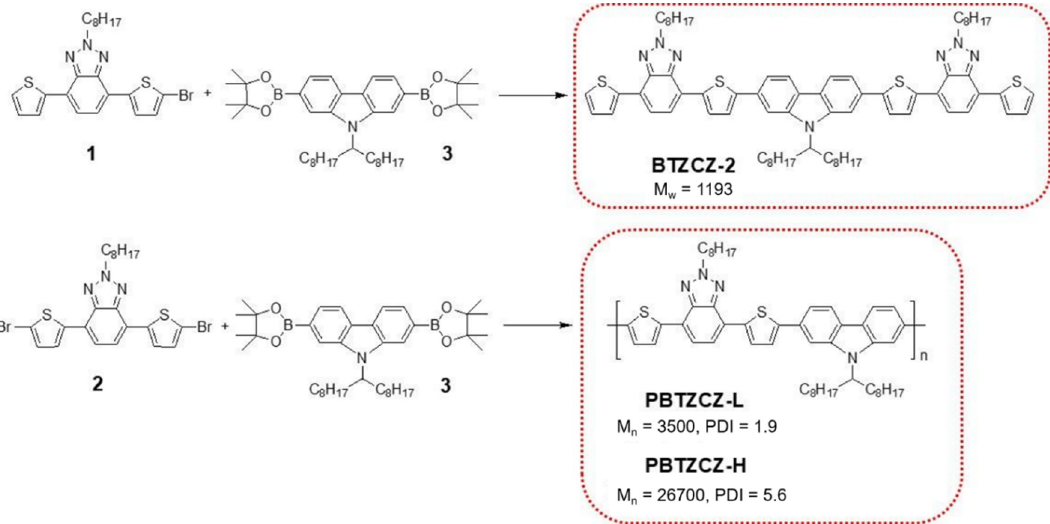
Table 1. Physical properties of the BTZCZ-2 , PBTZCZ-L , and PBTZCZ-H . Sample M n a PDI b (g mol − 1 )